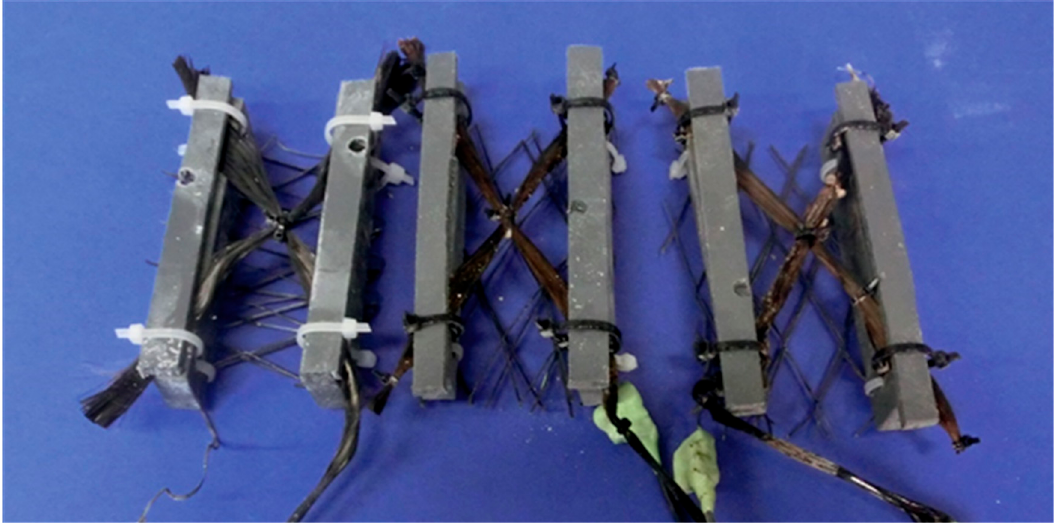
Figure 11. From left to right: specimen P1 of levels 1 to 3 after polarization.